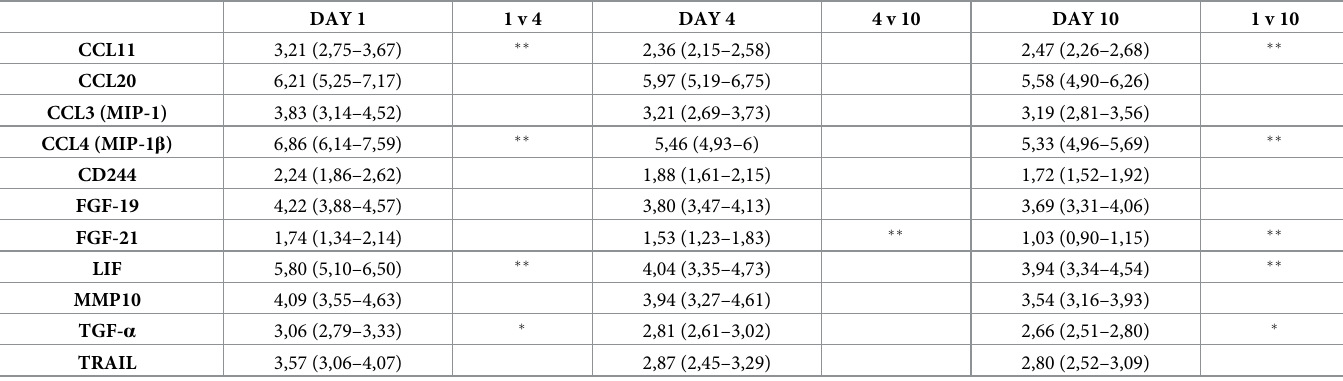
Table 3. Group A proteins.